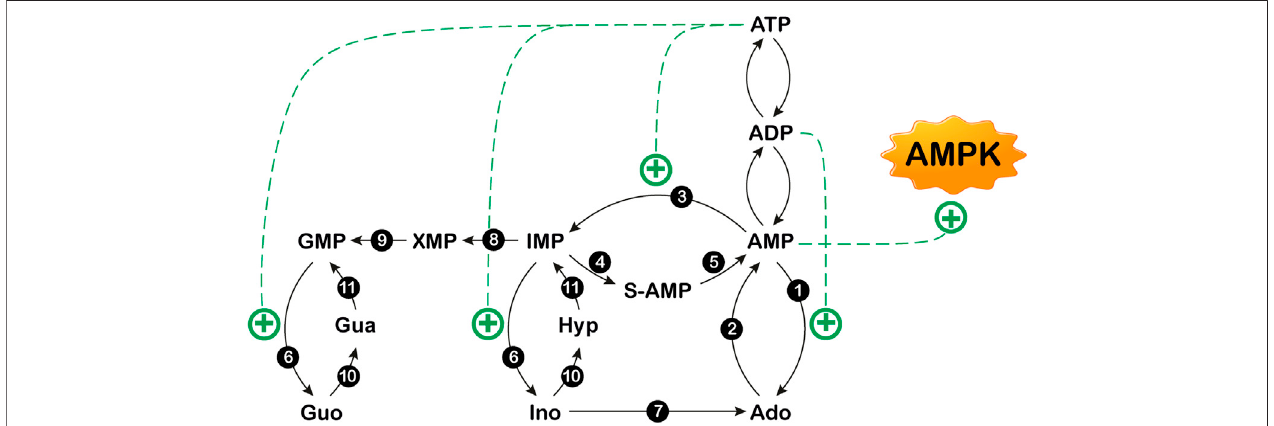
FIGURE 2 | Purine nucleotide cycles. 1: 5 ′ -nucleotidase I; 2: adenosine kinase; 3: AMP deaminase; 4: adenylosuccinate synthase; 5: adenylosuccinate lyase; 6: cytosolic 5 ′ -nucleotidase II; 7: adenosine deaminase; 8: IMP dehydrogenase; 9: GMP synthase; 10: purine nucleoside phosphorylase; 11: hypoxanthine guanine phosphoribosyltransferase. The fi gure also shows that AMP is an activator of AMP-activated protein kinase (AMPK). Ado: adenosine; Gua: guanine; Guo: guanosine; Hyp: hypoxhanthine; Ino: inosine. S-AMP: succinylAMP. +: stimulation.